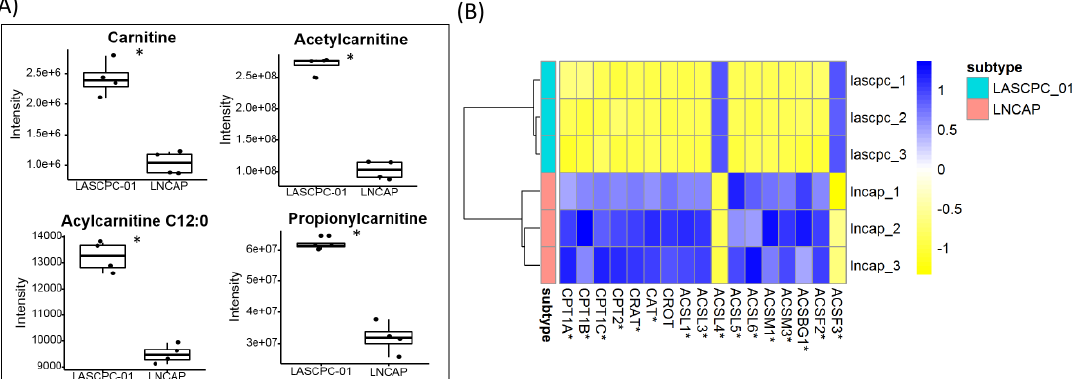
Figure 7. Carnitine system in two cell lines. ( A ) Lower levels of carnitine metabolites were found in LNCAP cell lines. ( B ) Detected transcripts in the carnitine transport system; *: p < 0.05.